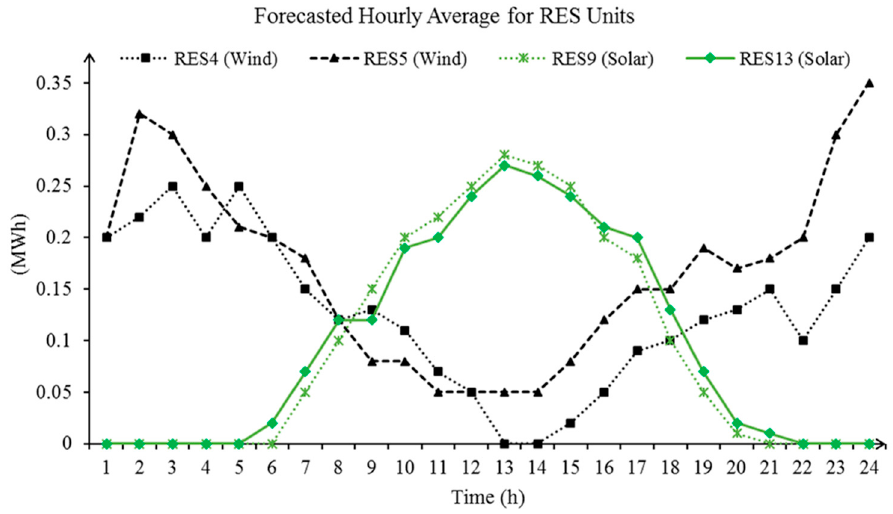
Figure 5. Wind and Solar forecasted hourly average generation.